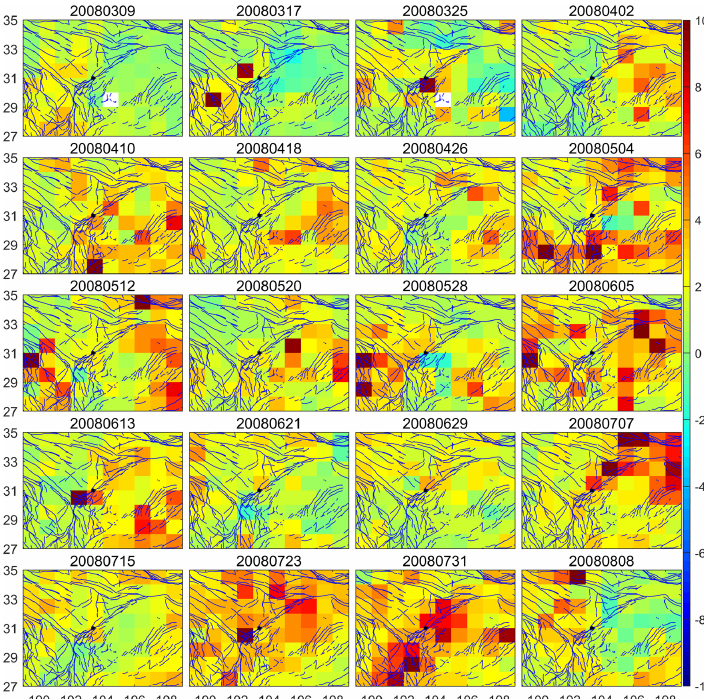
Figure 7. ALICE index of 8d CH 4 VMR at 400hPa.